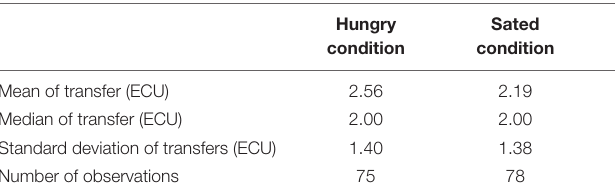
TABLE 3 | Mean transfer for treatment (sated) and control (hungry) groups. Panel A: Descriptive statistics on trust experiment transfer ( N = 153 transfer